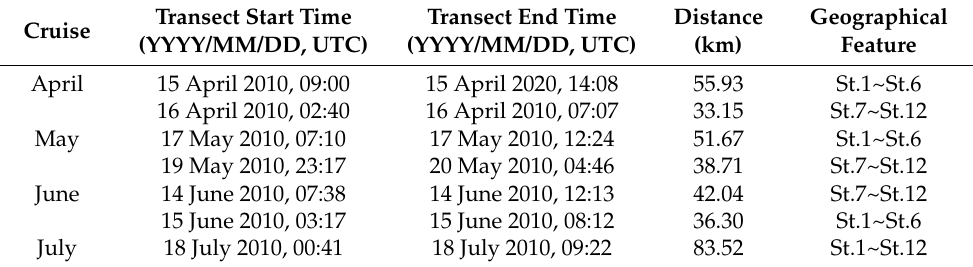
Table 1. Details of each acoustic transect survey from April to July